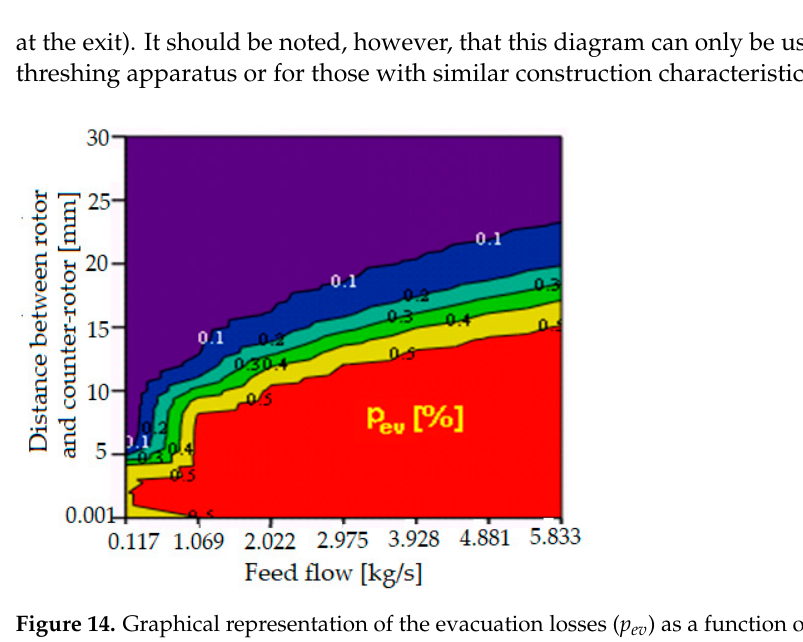
Figure 14. Graphical representation of the evacuation losses ( p ev ) as a function of space between the rotor and the counter-rotor ( δ ) and feed flow ( Q ).